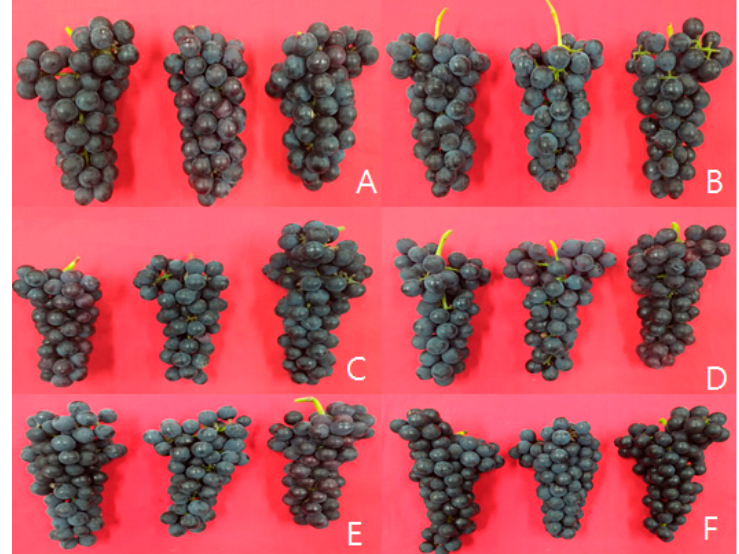
Figure 24. Changes in grape color with PV modules—no difference in coloration in all sections. ( A ) Normal control site, ( B ) normal solar-panel site, ( C ) bifacial control site, ( D ) bifacial solar-panel site, ( E ) transparent control site, and ( F ) transparent solar-panel site.